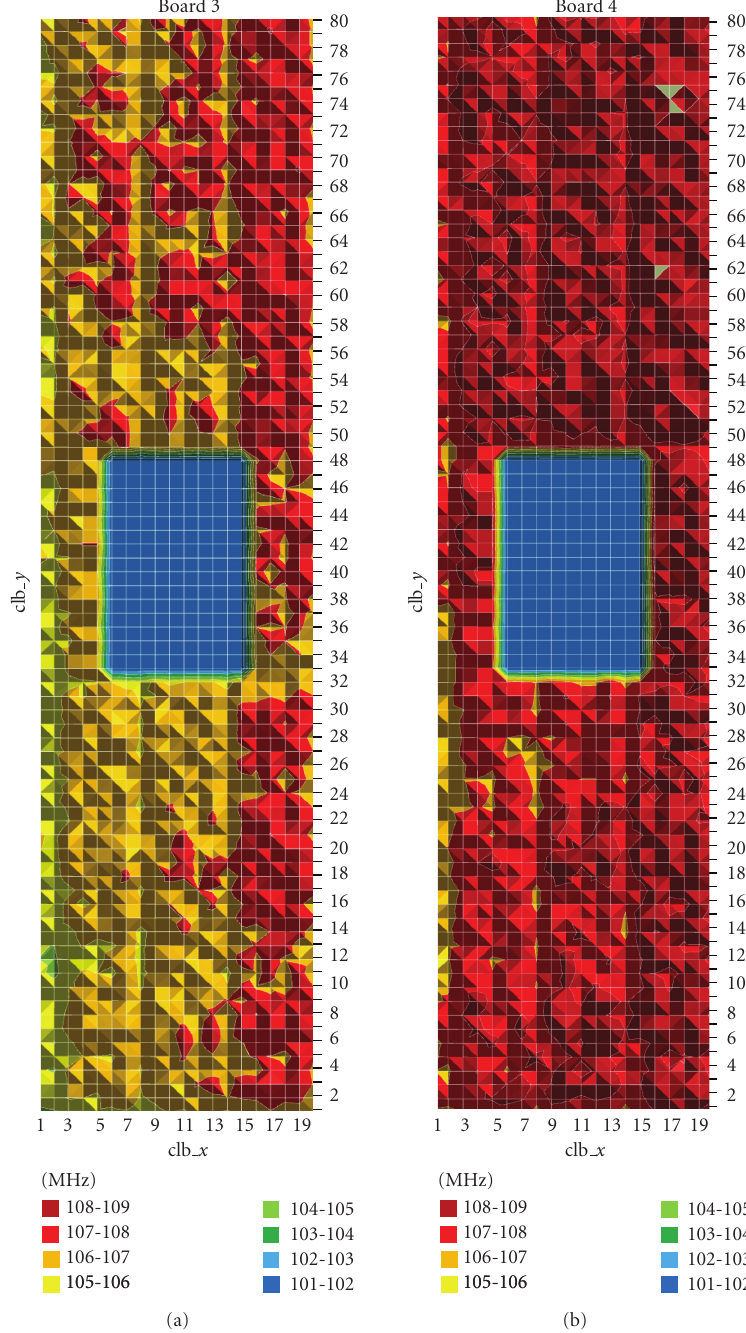
Figure 12: OSC frequency map (MHz) board 3/board